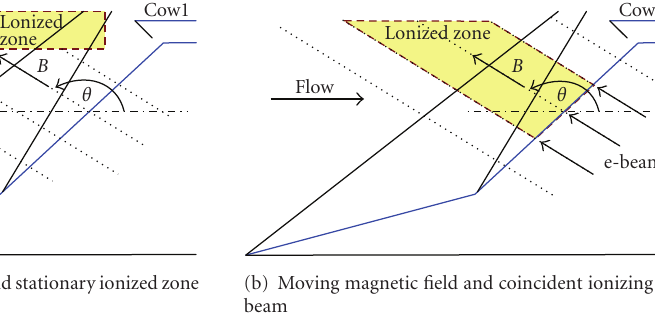
Figure 3: Application of magnetic field and ionized